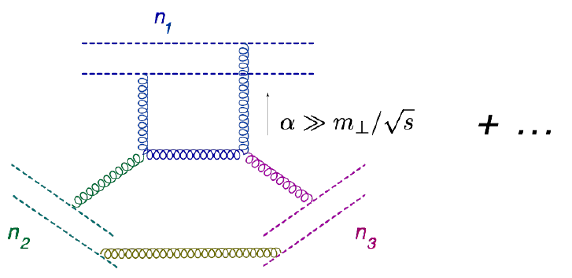
Figure 14 . Leading diagrams with logarithmic integrals over (cid:11)